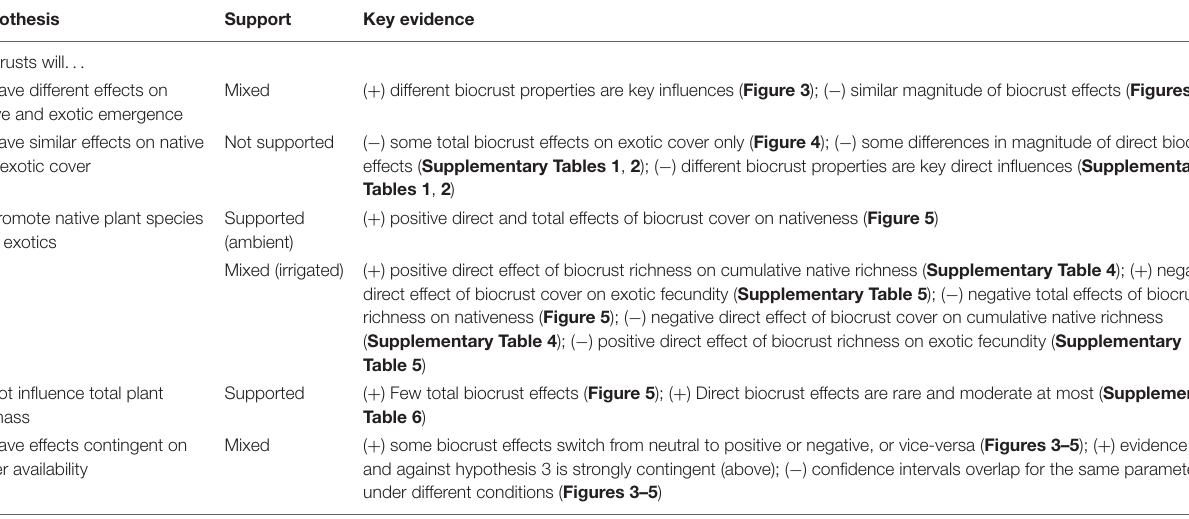
TABLE 1 | Summary of support for our hypotheses. Hypothesis Support Key evidence Biocrusts will ...